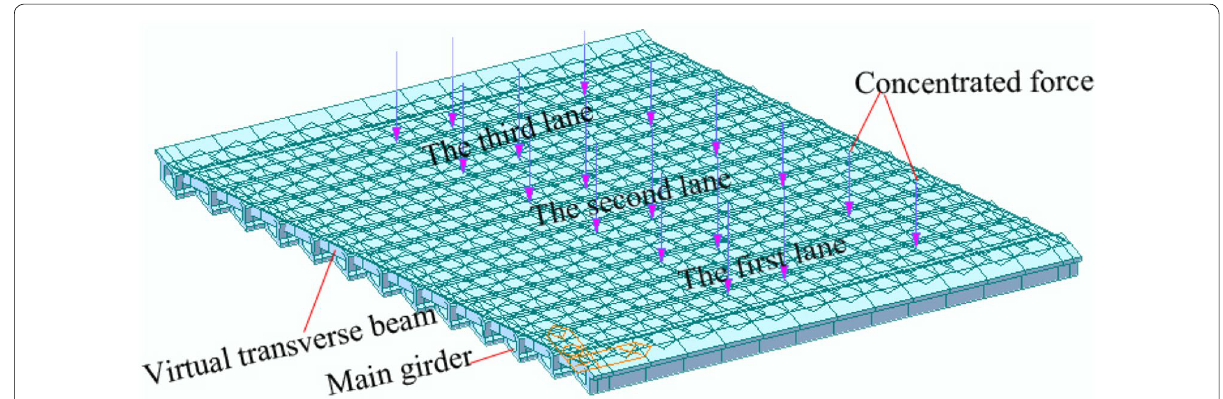
Fig. 14 FEM with three loaded lanes.